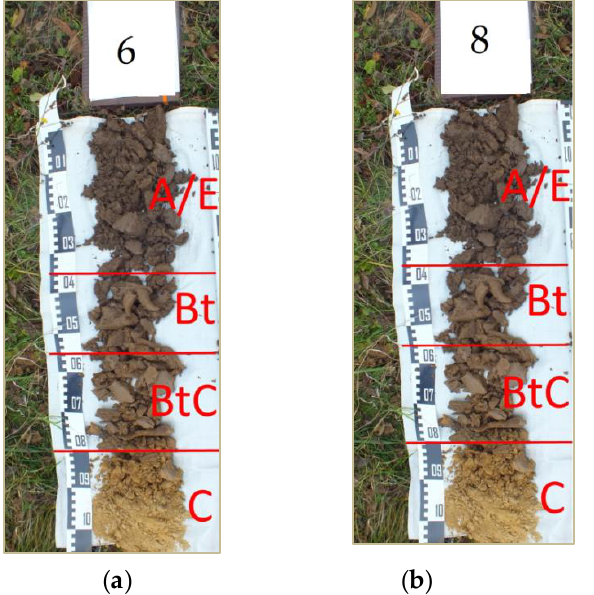
Figure 6. Some of the soil profiles: ( a ) Svrljig locality—abruptic luvisol (clayic), LV-ap-ce; ( b ) Malča locality —haplic vertisol, VR-ha-oh.